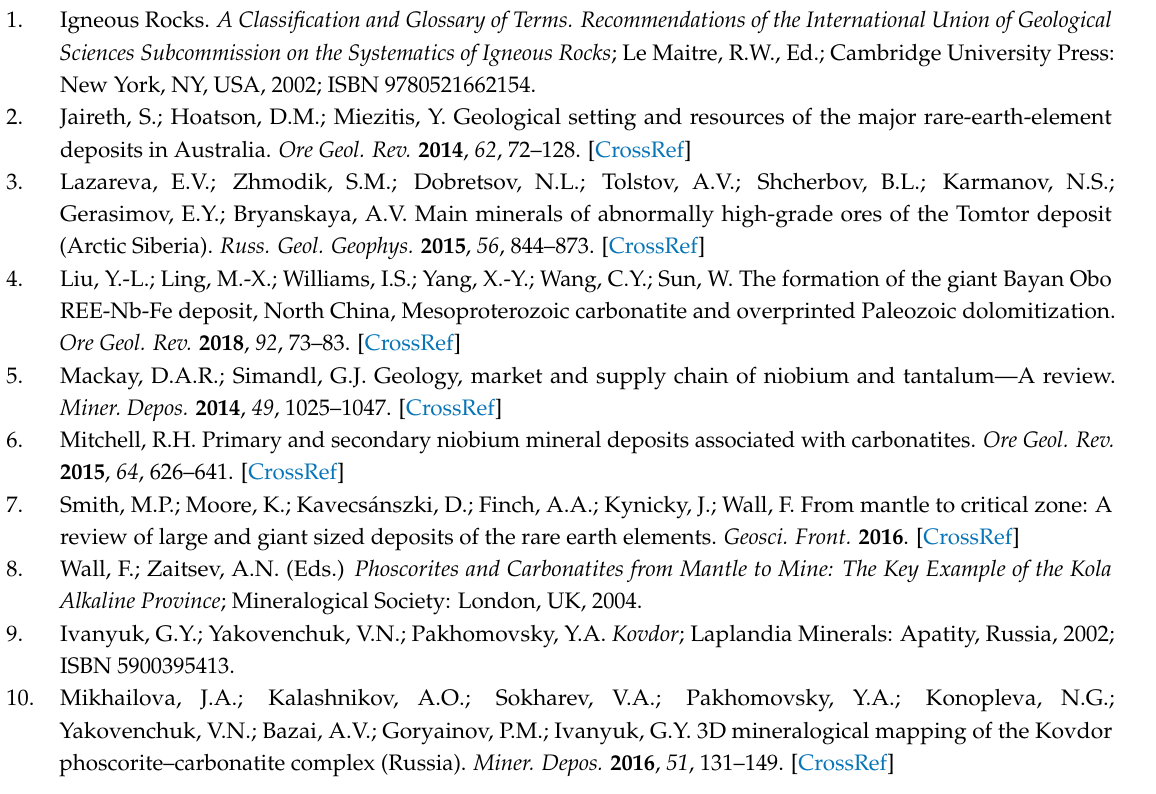
lengths for Forsterite_1, Table S4: Atomic occupancy for Forsterite_1. Table S5: Fractional atomic coordinates ( × 10 4 ) and equivalent isotropic displacement parameters (Å 2 × 10 3 ) for Forsterite_2. Table S6: Anisotropic displacement parameters (Å 2 × 10 3 ) for Forsterite_2. Table S7: Bond lengths for Forsterite_2, Table S8: Atomic occupancy for Forsterite_2, Table S9: Fractional atomic coordinates ( × 10 4 ) and equivalent isotropic displacement Table S11: Bond lengths for Forsterite_3, Table S12: Atomic occupancy for Forsterite_3, Table S13: Fractional atomic coordinates ( × 10 4 ) and equivalent isotropic displacement parameters (Å 2 × 10 3 ) for Forsterite_4. Table S14: Anisotropic displacement parameters (Å 2 × 10 3 ) for Forsterite_4. Table S15: Bond lengths for Forsterite_4, Table S16: Atomic occupancy for Forsterite_4, Table S17: Fractional atomic coordinates ( × 10 4 ) and equivalent isotropic displacement parameters (Å 2 × 10 3 ) for Forsterite_5. Table S18: Anisotropic displacement parameters (Å 2 × 10 3 ) for Forsterite_5. Table S19: Bond lengths for Forsterite_5, Table S20: Atomic occupancy for